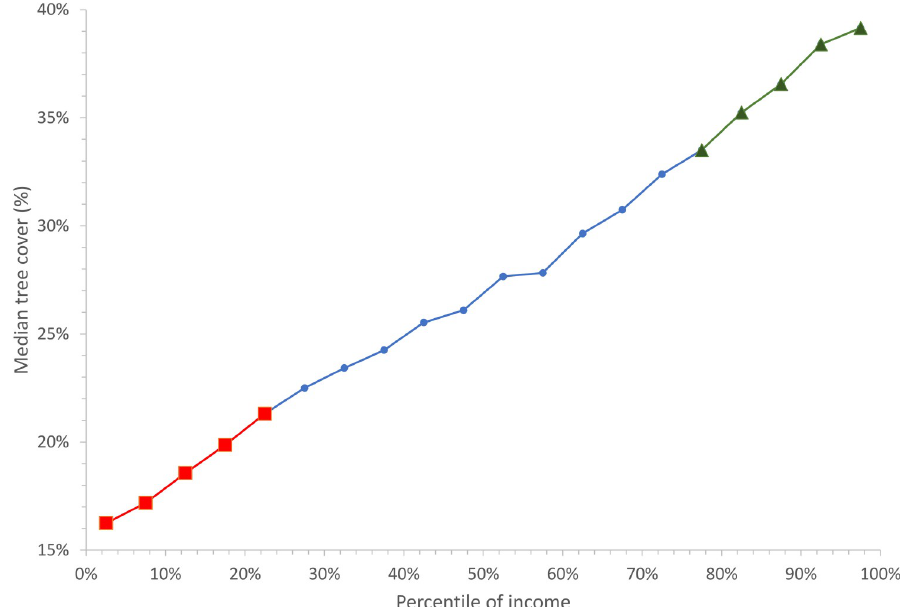
Fig 2. Tree cover as a function of income. We classified census blocks based upon the income distribution within its urbanized area, calculating the percentile of the income distribution that block has. For ease of display, blocks were grouped into income categories (0–5%, 5–10%, etc.) and the population-weighted median tree cover (%) across the entire study area calculated. This paper focuses most of its analysis on the lowest quartile (red squares) and highest quartile (green triangles) of income.